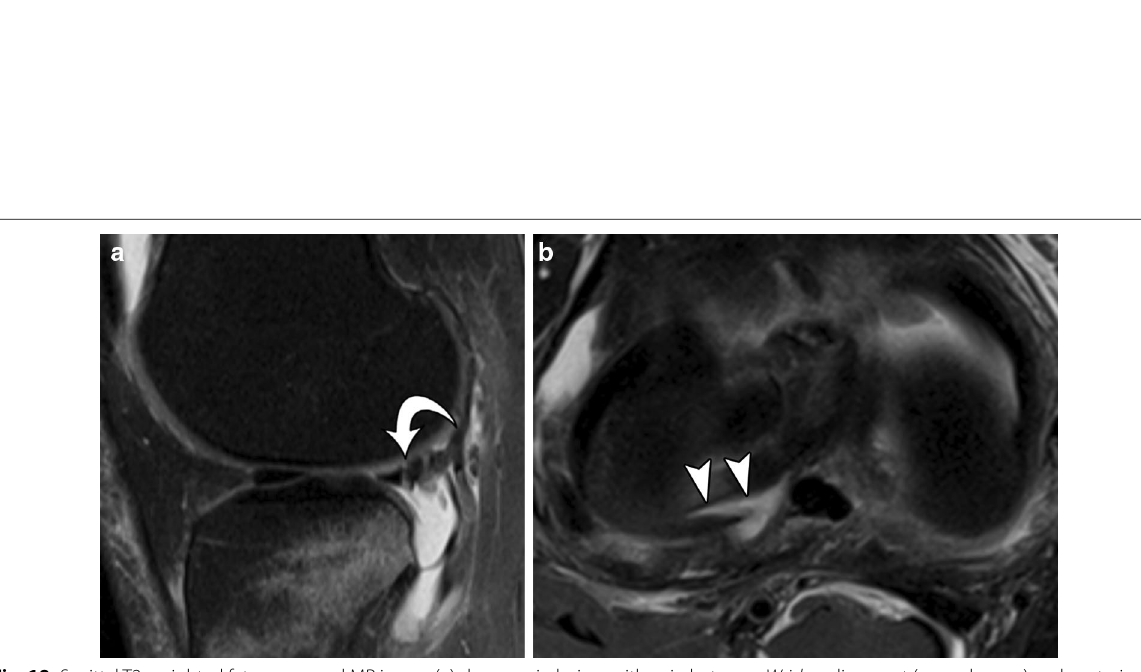
Fig. 18 Sagittal T2‑weighted fat‑suppressed MR image ( a ) shows a zip lesion, with a rip between Wrisberg ligament (curved arrow) and posterior horn of lateral meniscus. Axial T2‑weighetd fat‑suppressed MR image ( b ) shows the lesion in a cross‑sectional view